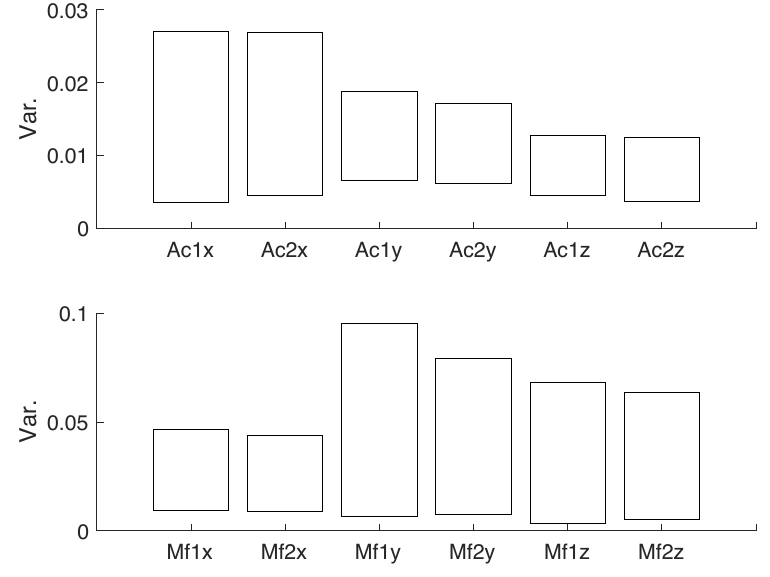
Figure 6. Plots of the Allen variance on IMU sensors ( top ) Accelerometer (Ac) and ( bottom ): Magnetic Force (Mf). Results are shown for two sensors (1–2), and on each cardinal axis (x, y,